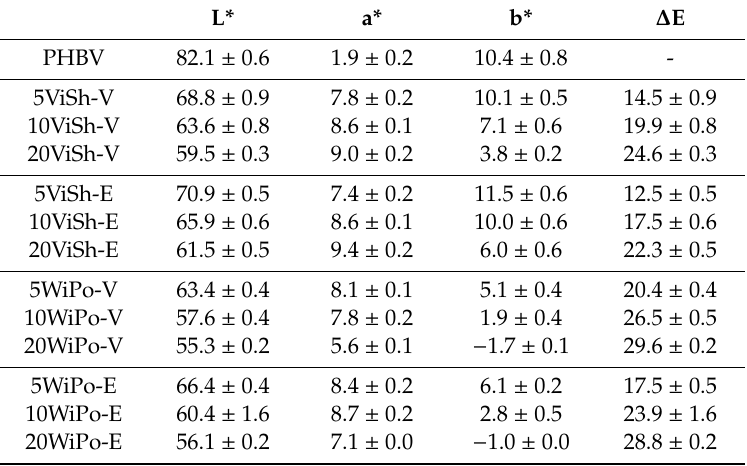
Table 4. Color attributes of the PHBV-based composite films.